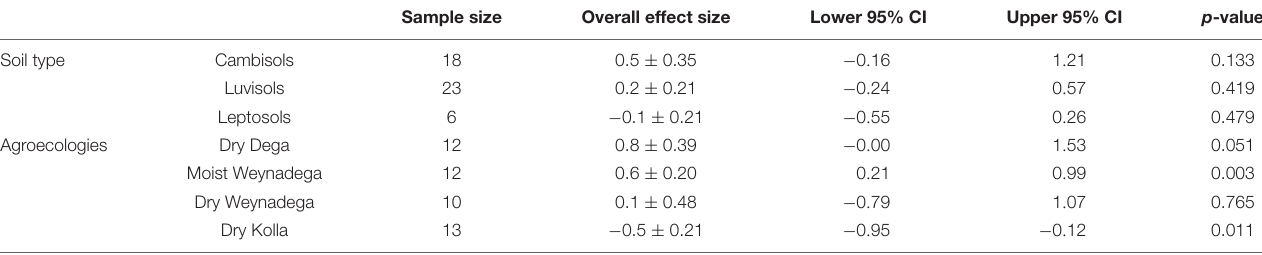
TABLE 6 | Changes in soil pH following the establishment of exclosures on communal grazing lands.